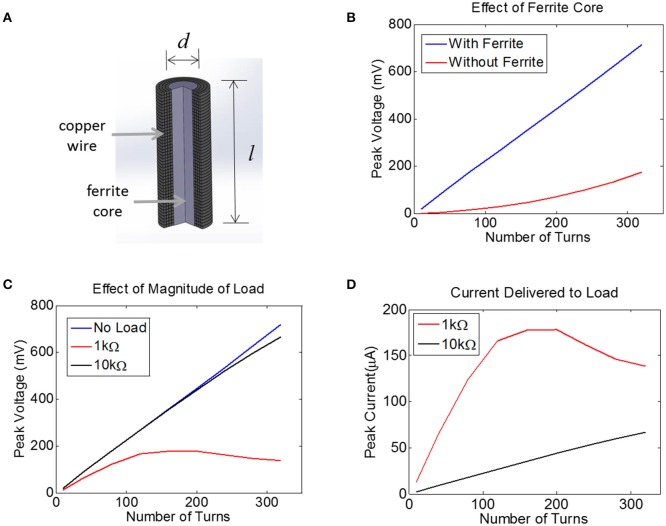
(A) Finite-Element Model of a multi-turn coil with ferrite core used to estimate induced voltage in COMSOL. A cross-section is shown to illustrate winding. (B) The peak voltage induced in a coil with d = 0.2 mm and l = 1.0 mm is plotted as a function of the number of turns, both with a ferrite core (blue) and an air core (red), assuming a 10 MHz transmit frequency with the maximum allowed magnetic field of 40A/m, with 52 AWG copper. (C) Assuming a 0.2 mm coil with a ferrite core, the peak voltage is plotted for three different load conditions: no load (open circuit, blue), 1 kΩ (red), and 10 kΩ (black). (D) For the data in panel (C) the peak current is plotted for two different loads, 1 kΩ and 10 kΩ.